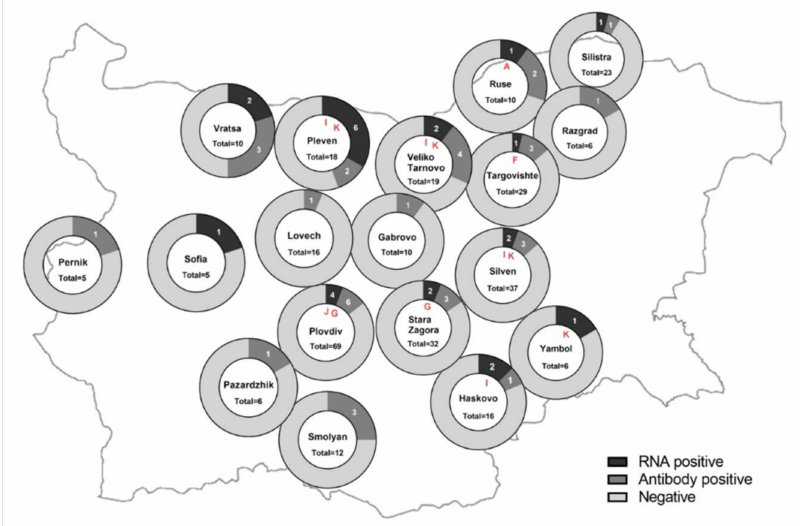
Figure 1. Detection rates of BovHepV genomes and BovHepV anti-NS3 antibodies in different regions of Bulgaria. The total number of investigated samples, the number of RNA positive and serologically reactive samples and the respective geographical origin are shown. The circulating BovHepV subtypes are depicted in the central circle and marked in red. The map was downloaded from GinkgoMaps [http://ginkgomaps.com accessed on 1 January 2022] and the illustrations were created with GraphPad